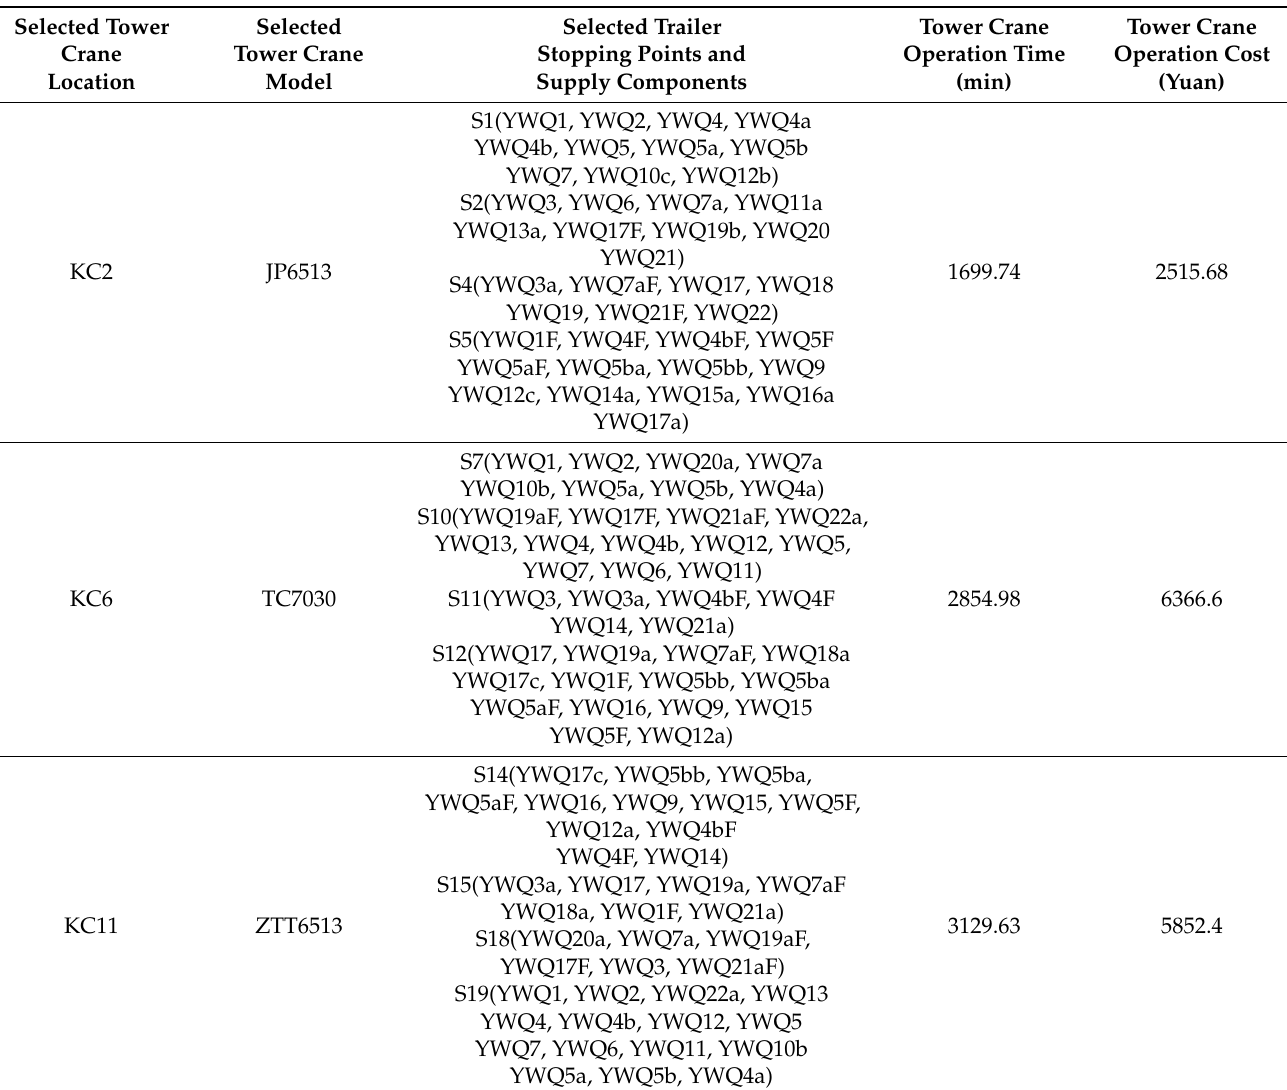
Table 7. Optimization result